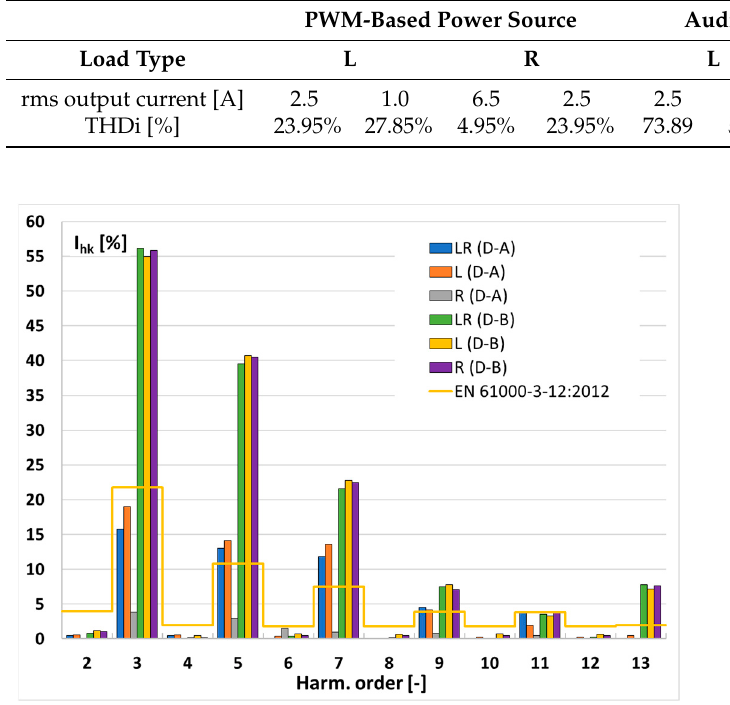
Figure 11. Percentage values of a given higher harmonics in suppling current of the PWM-based power source (D-A) and audio power amplifier (D-B). power source (D-A) and audio power amplifier Table 1. The values of THDi factors of supply currents of tested PWM-based power source and audio power amplifier.